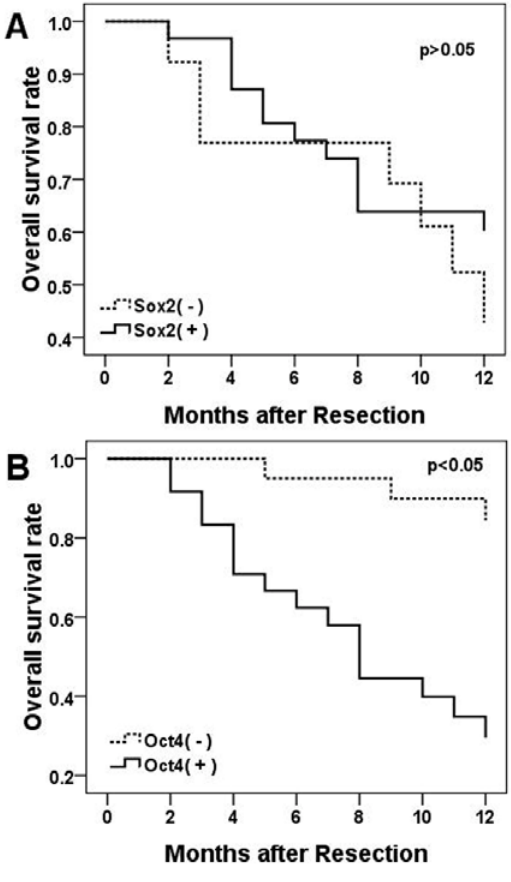
Figure 3. Kaplan-Meier curves for overall survival rates according to Sox2